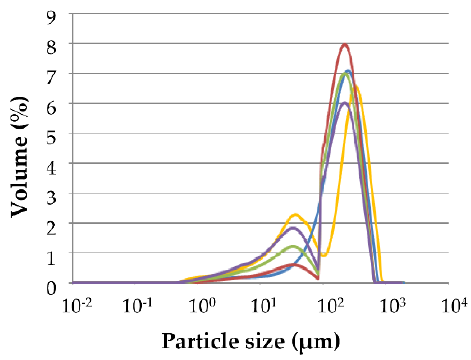
Figure 2. Particle size distribution of quartz sand (yellow), RGA mix for PC0 (light blue), RGA mix for PC10 (red), RGA mix for PC20 (green), RGA mix for PC30 (violet).